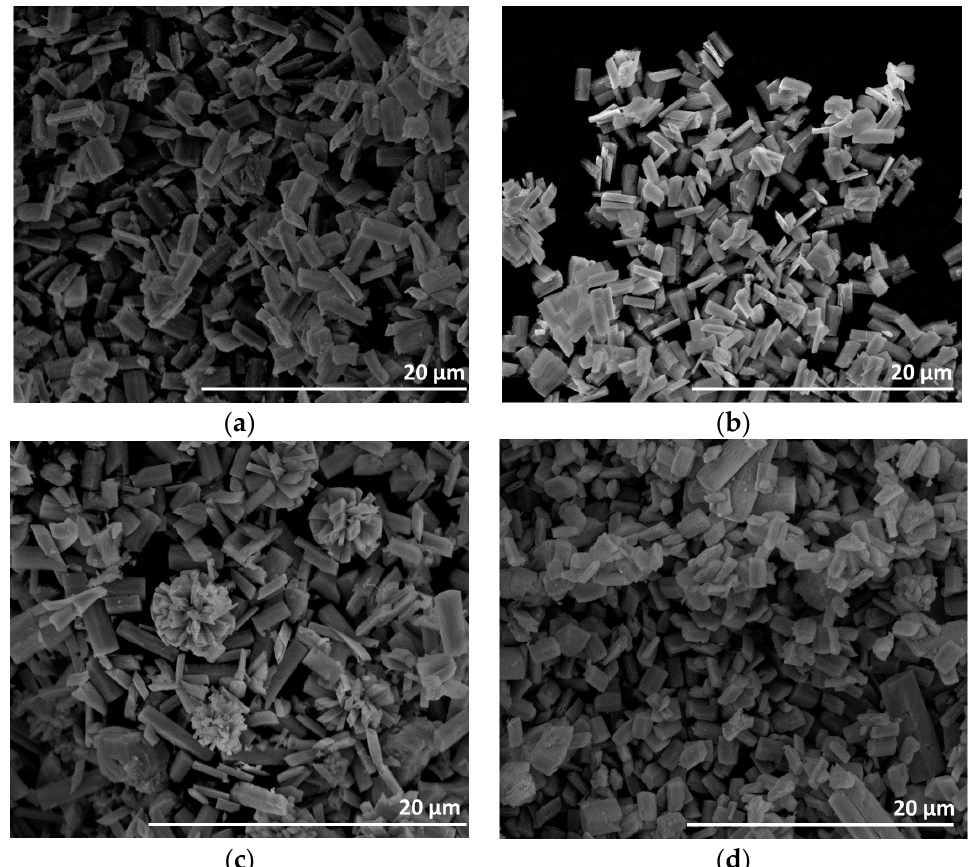
Figure 7. SEM images of post-reaction recycled gallium oxide nanoplates synthesized using CTAB with different precursor:surfactant:solvent ratios ( a ) 1:1.6:740; ( b ) 1:3.2:740; ( c ) 1:4.8:740; ( d ) no surfactant.